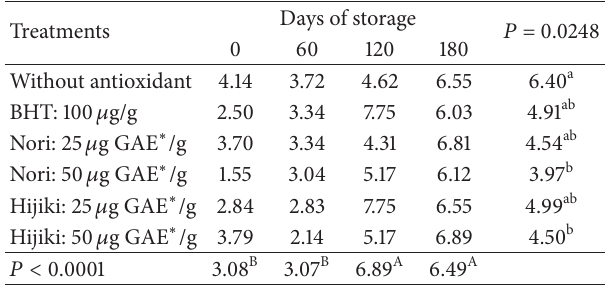
Table 4: Total volatile base nitrogen (mgn/100g) of minced tilapia stored for 180